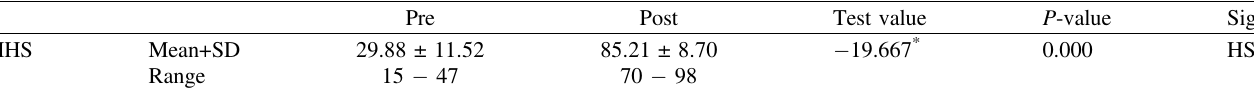
Figure 5. (A) Preoperative X-ray for a case with acetabular aseptic loosening, (B) postoperative X-ray after revision using Delta TT revision system with stem retention. Table 3. Comparison between pre and post regarding